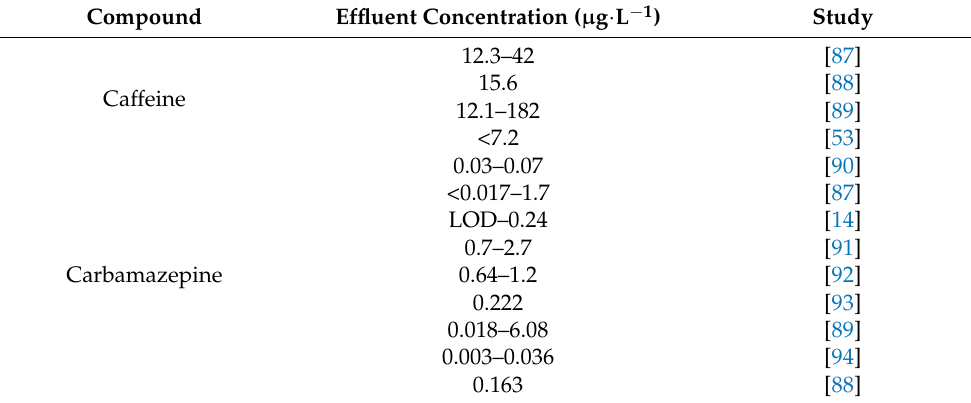
Table 5. Monitoring of the occurrence of specific micropollutants in effluents from healthcare facilities after the treatment